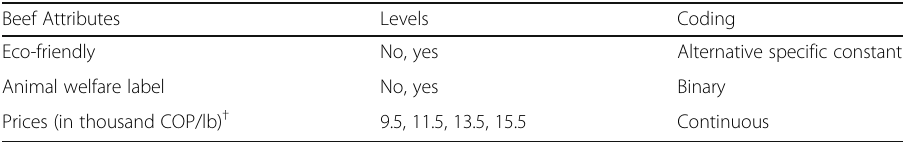
Table 1 Experimental design — choice alternatives and levels Beef Attributes